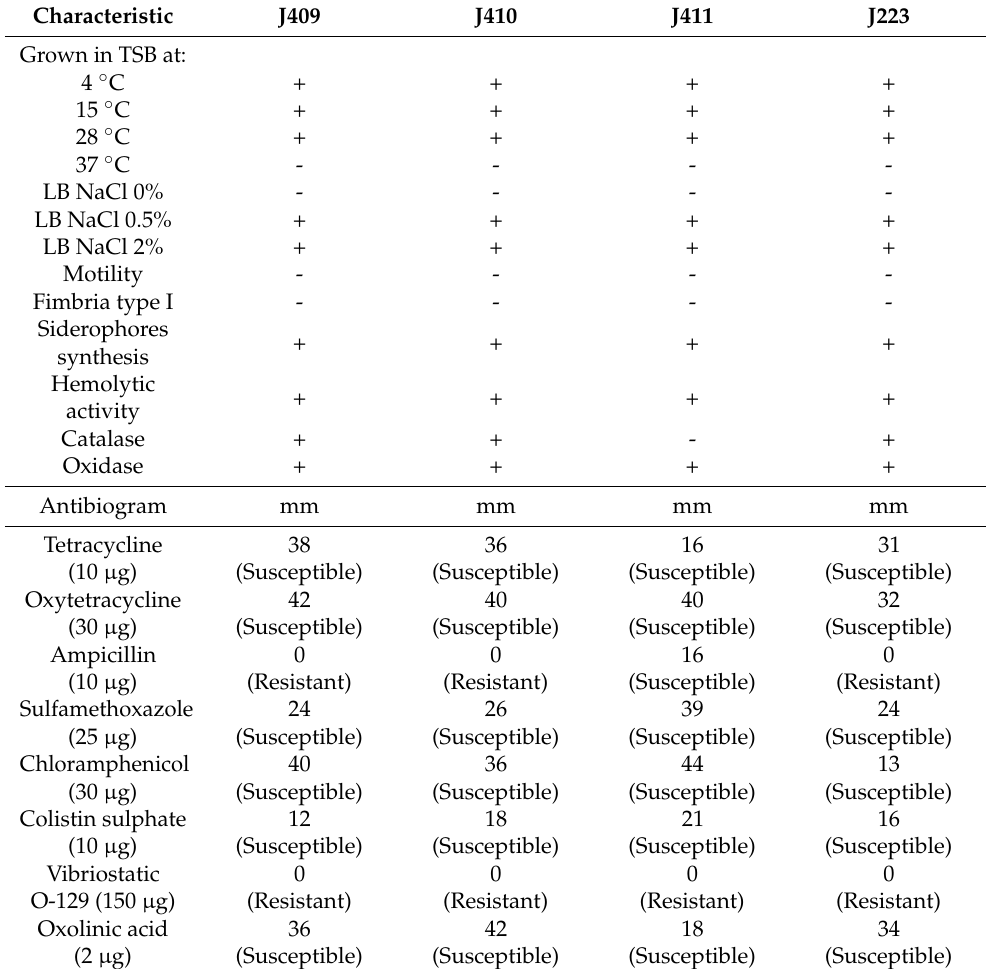
Table 2. Phenotypic characteristics of A. salmonicida strains J409, J410, J411, and J223. Except where indicated, all the tests were performed at 15 ◦